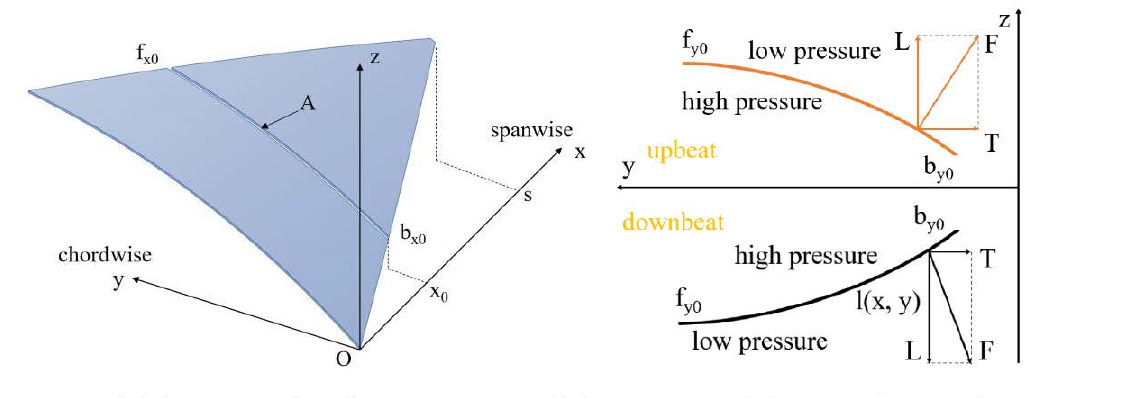
Figure 1. Force analysis of two-dimensional pectoral fins.